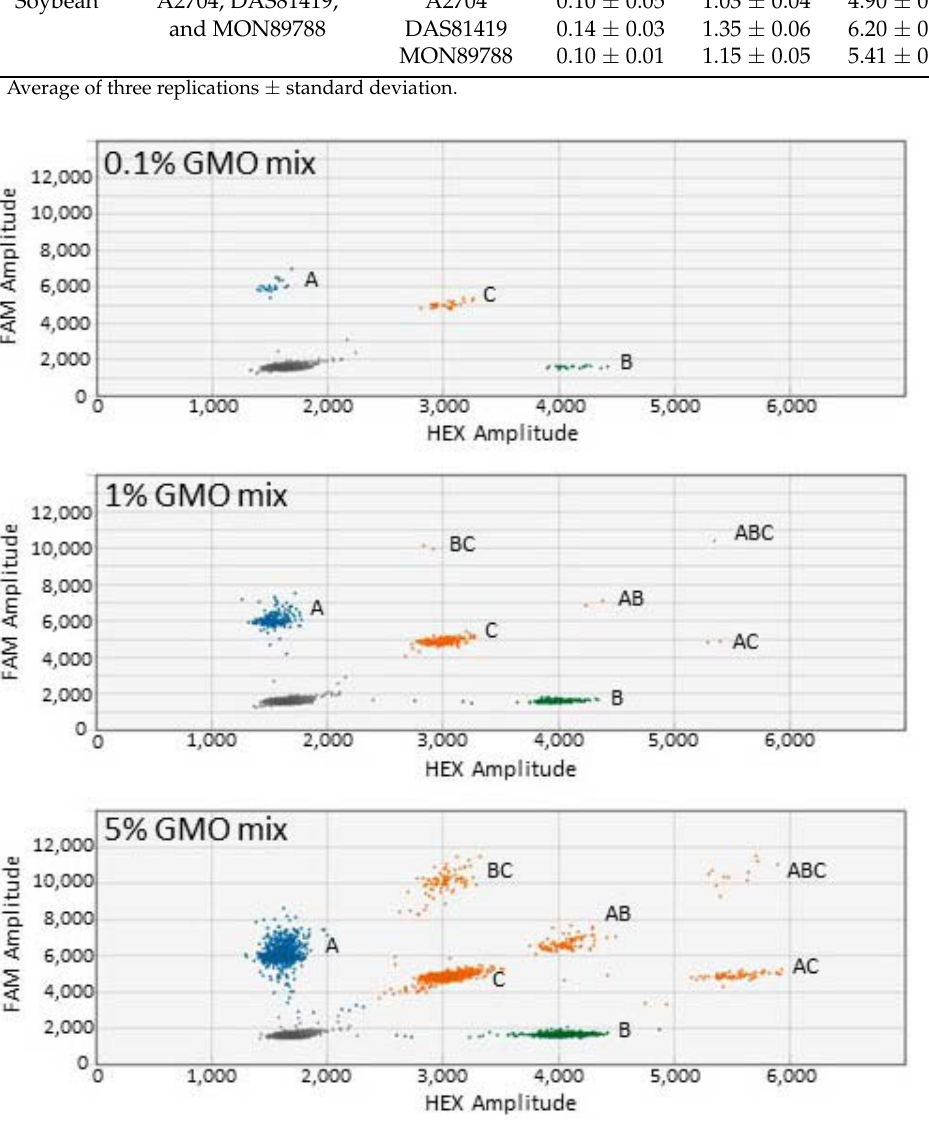
Figure 3. Droplet clusters generated for the canola triplex ddPCR assay (two-dimensional view). A = HCN92 (FAM); B = GT73 (HEX); C = MON88302 (FAM and HEX). The dark cluster represents negative droplets.